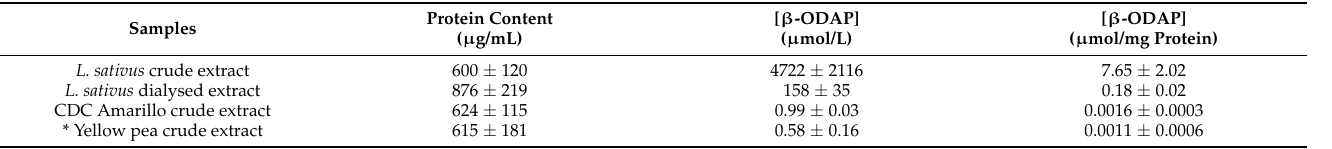
Table 4. β -ODAP concentrations found in L. sativus, CDC Amarillo, and yellow pea extracts. An external calibration curve of β -ODAP was used for quantitation, using Gly-Asp as the internal